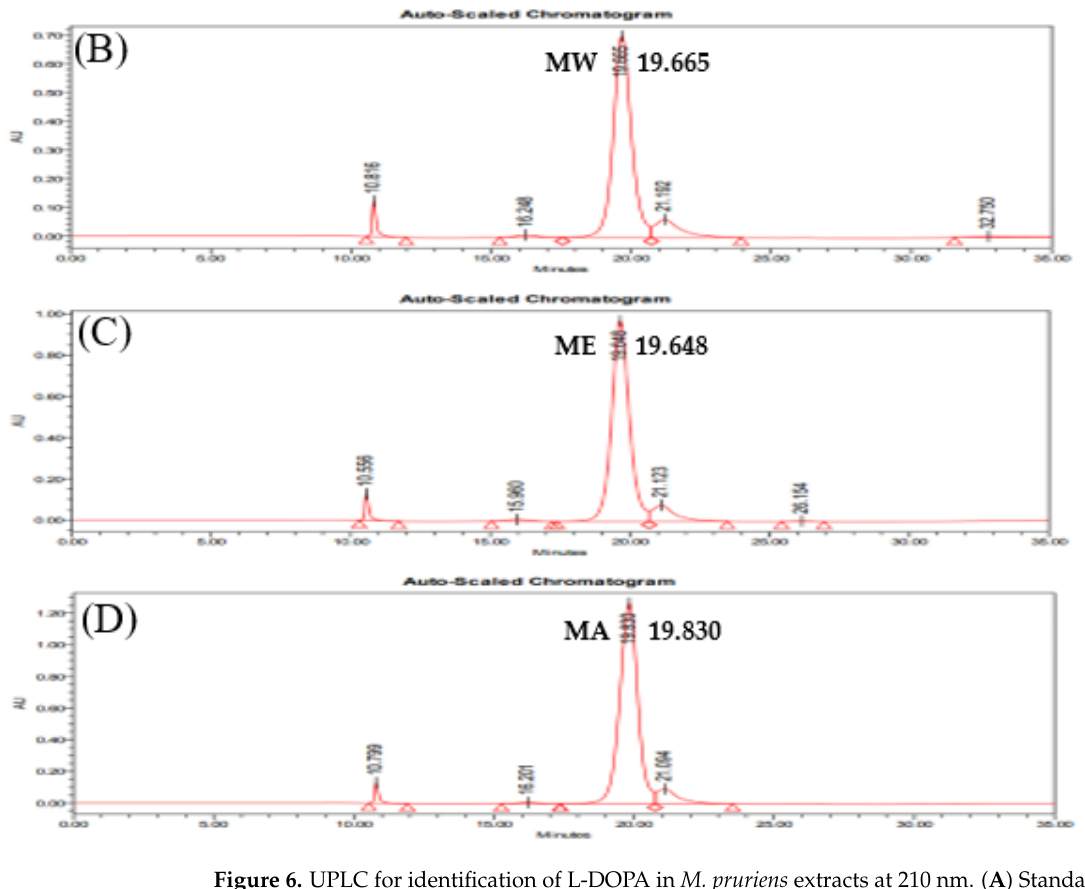
Figure 6. UPLC for identification of L-DOPA in M. pruriens extracts at 210 nm. ( A ) Standard material, ( B ) MW, ( C ) ME, and ( D ) MA.